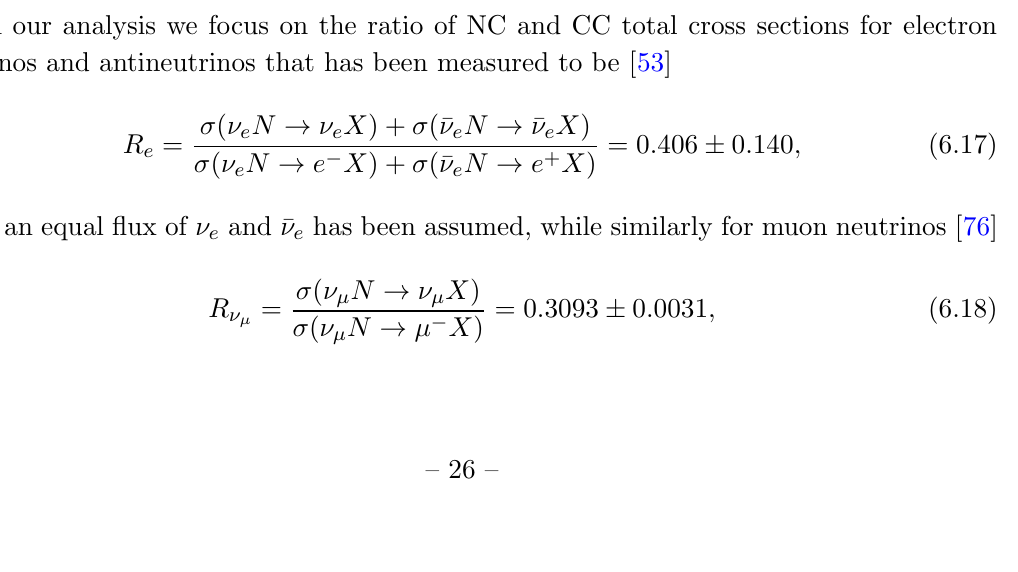
Figure 8 . E(cid:11)ect at high recoil energy of the operator di(cid:11)erent neutrino energies, using monochromatic neutrino beams for illustration. The black dashed line is the SM